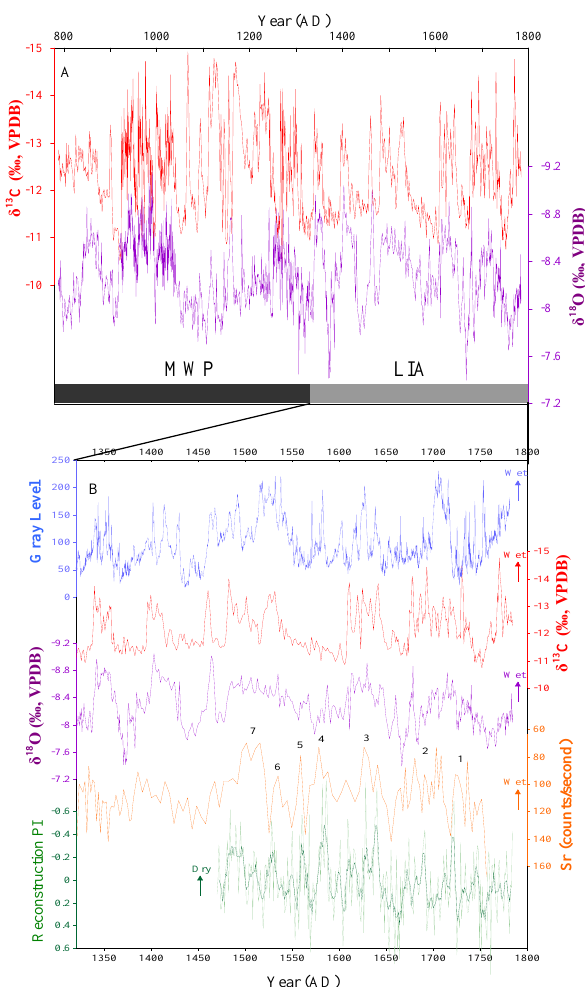
Fig. 6. (A) the δ 18 O (purple curve) and δ 13 C (red curve) time series. (B) detailed comparison of multi-proxy records from stalagmite BD and reconstruction precipitation index (PI) from Northern China (Yi et al., 2012), deep green line is 5-point running mean. The numbers indicate wet periods at the cave site over the mid-low Yangtze River